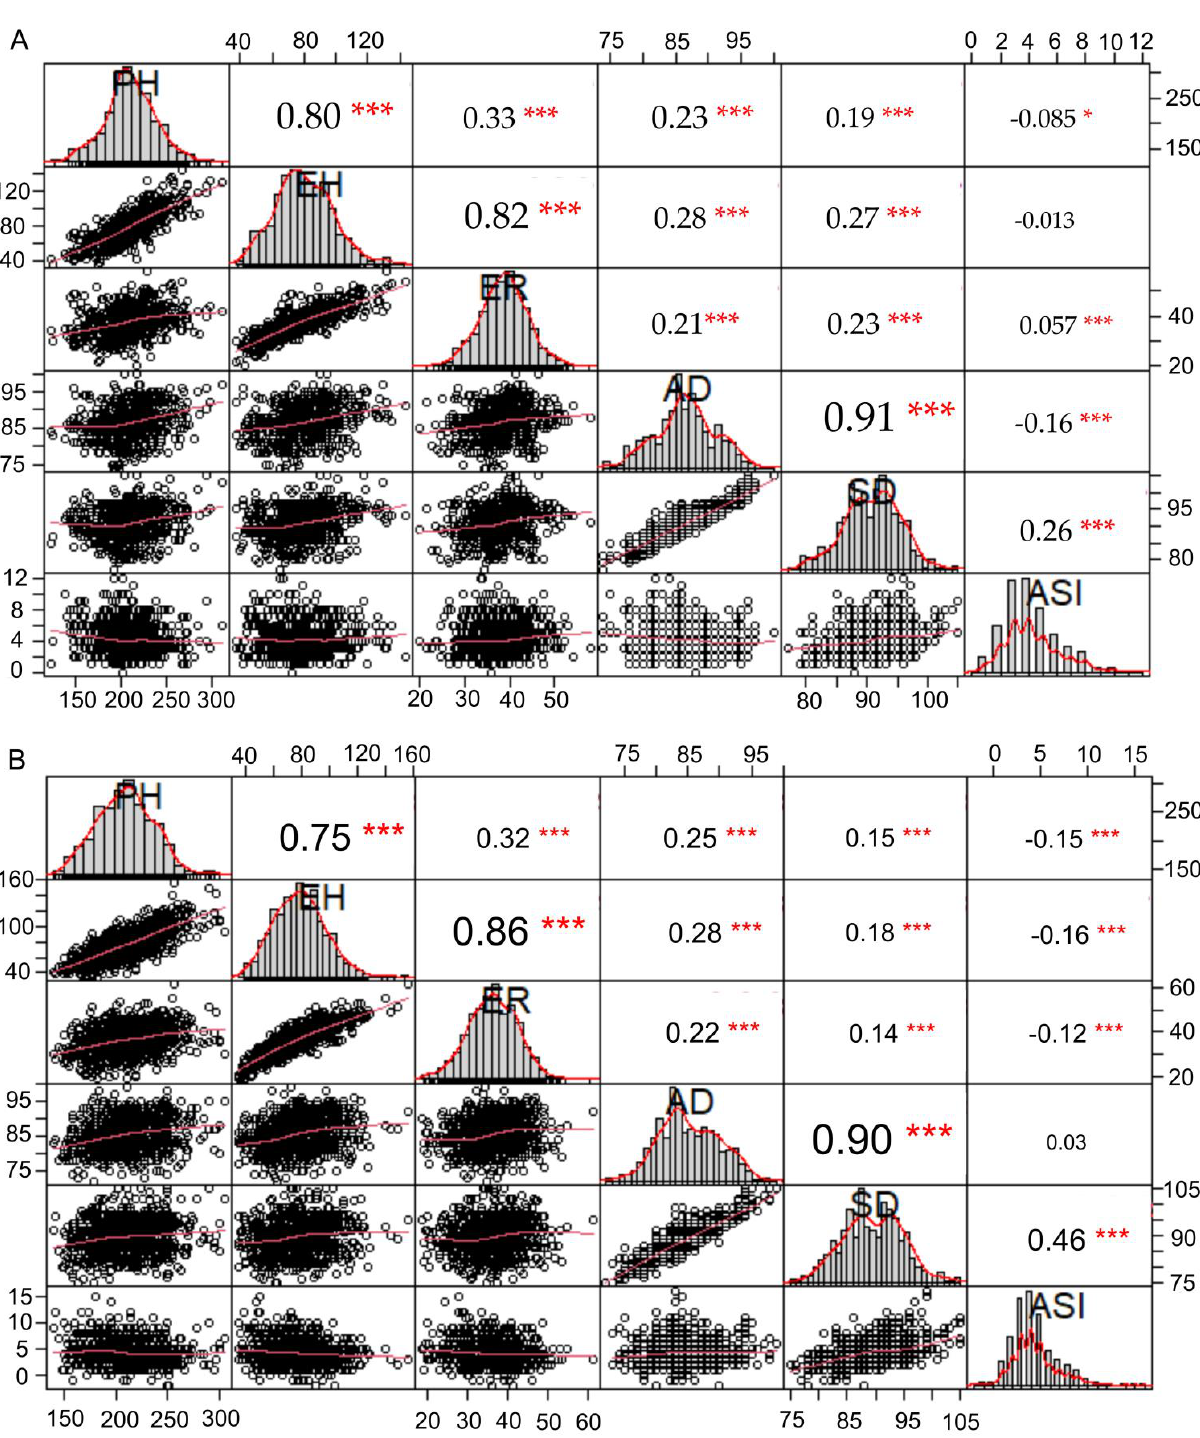
Figure 1. Distribution plot of phenotypic value and the Pearson correlation coefficient among different traits in the DH lines of the two DH populations: ( A ) panel represents QY population; ( B ) panel represents QZ population. On the diagonal are the bar plots of phenotypic distributions for the six traits; below the diagonal is the regression graph, and each sub-graph represents a regression of two corresponding traits on the diagonal; above the diagonal is the Pearson correlation coefficient, and each sub-graph represents a correlation coefficient of two corresponding traits on the diagonal. The “*” and “***” above the correlation coefficient represent significant p- value < 0.05 and 0.001, respectively.